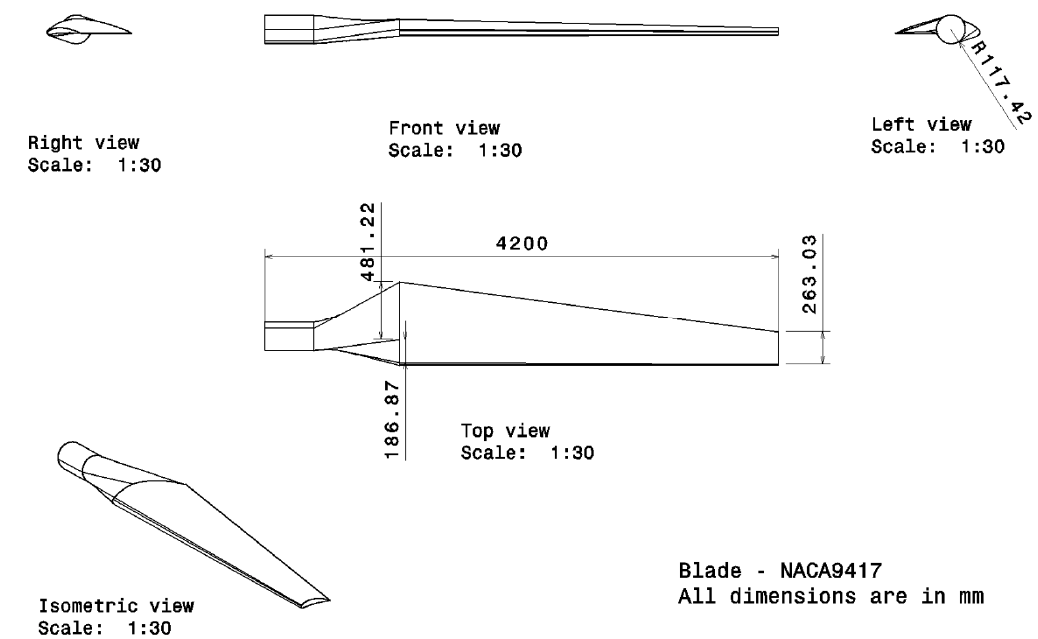
Figure 4. Design draft of wind turbine blade.